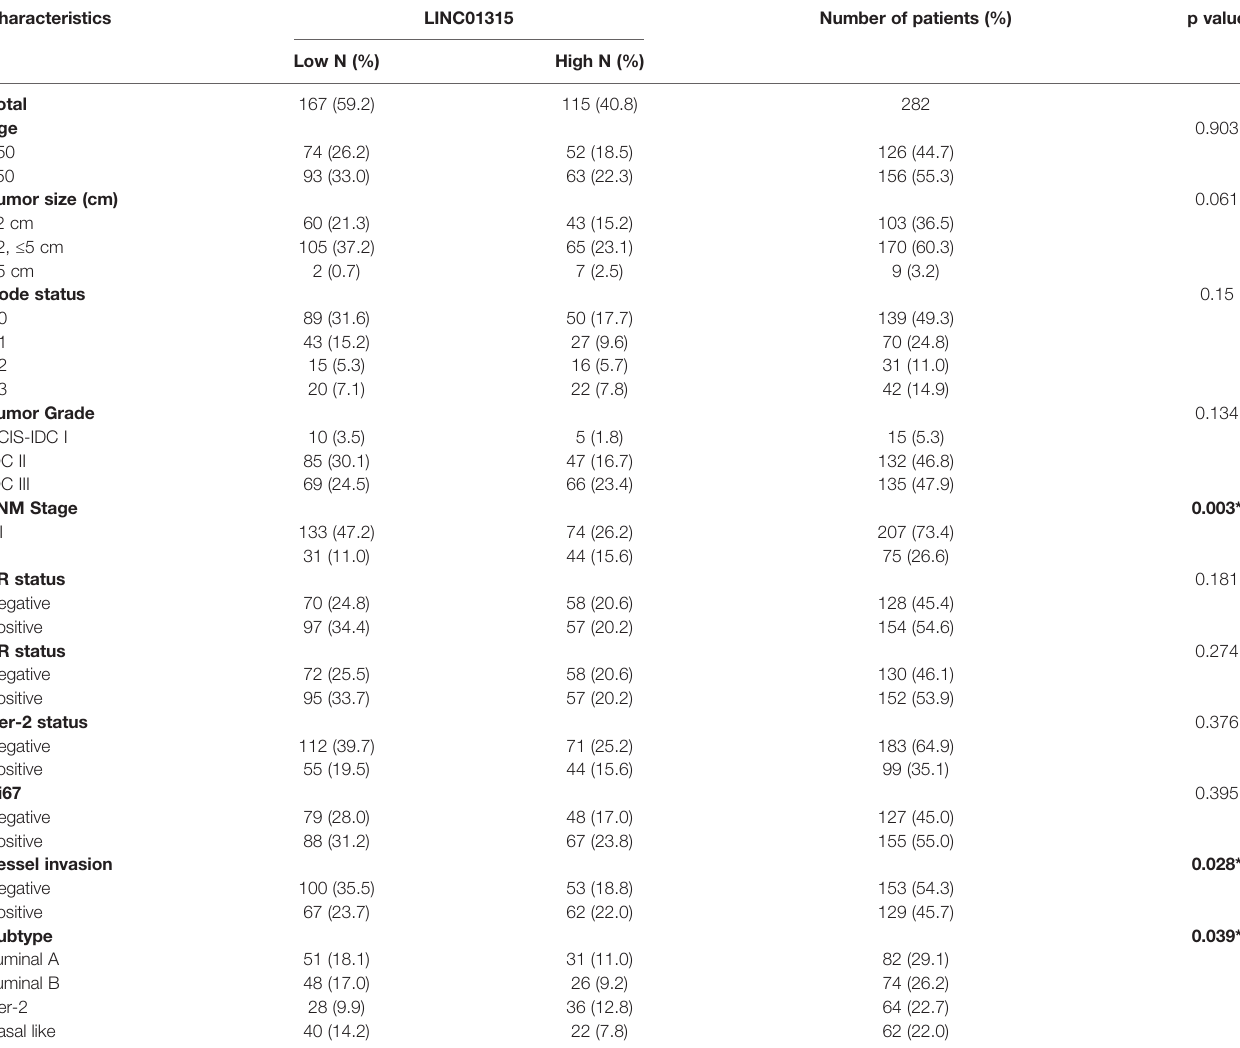
TABLE 1 | Clinical information and demographics of the 282 patients included in the study.